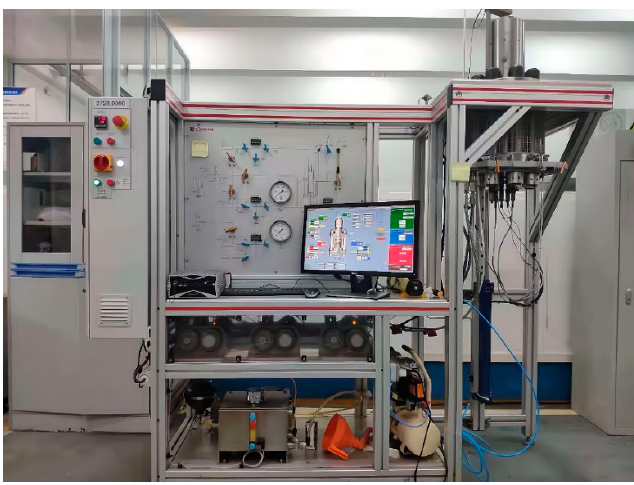
(Figure 5) . The SEM (scanning electron microscope) resolution was 1.0 nm @ 15 kV, and the acceleration voltage was 0.1 kV–30 kV.